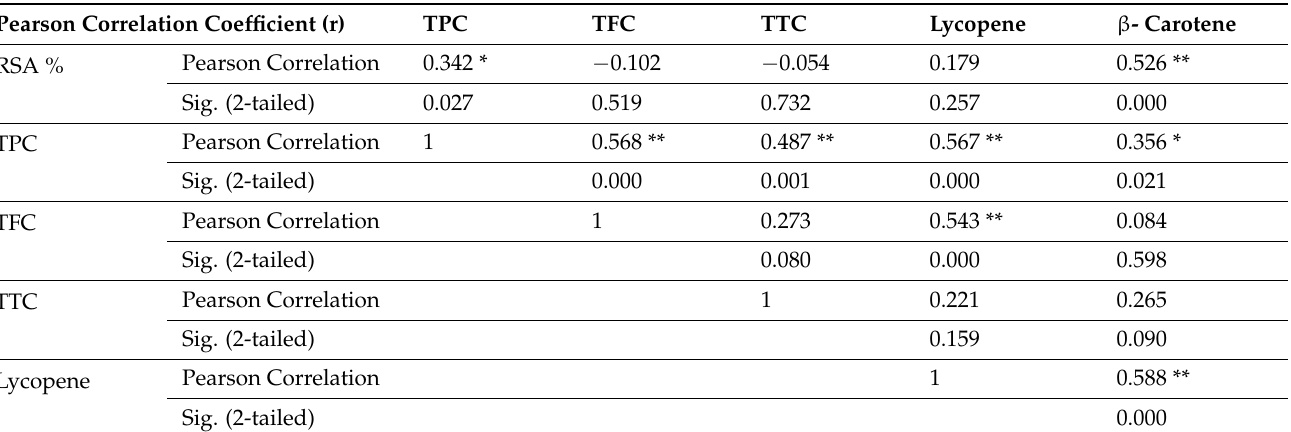
Table 5. The intensity of the correlations between the phenolic content (TPC, TTC, TFC), carotenoids (lycopene and β -carotene), and antiradical activity of dehydrated chokeberry